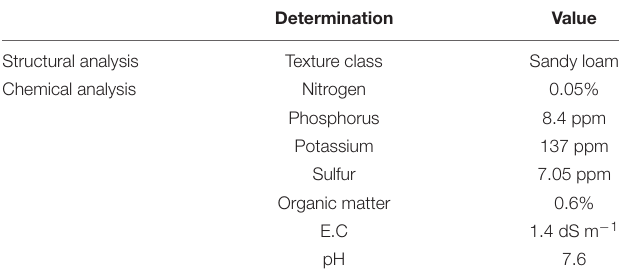
TABLE 2 | Physio-chemical analyses of soil before